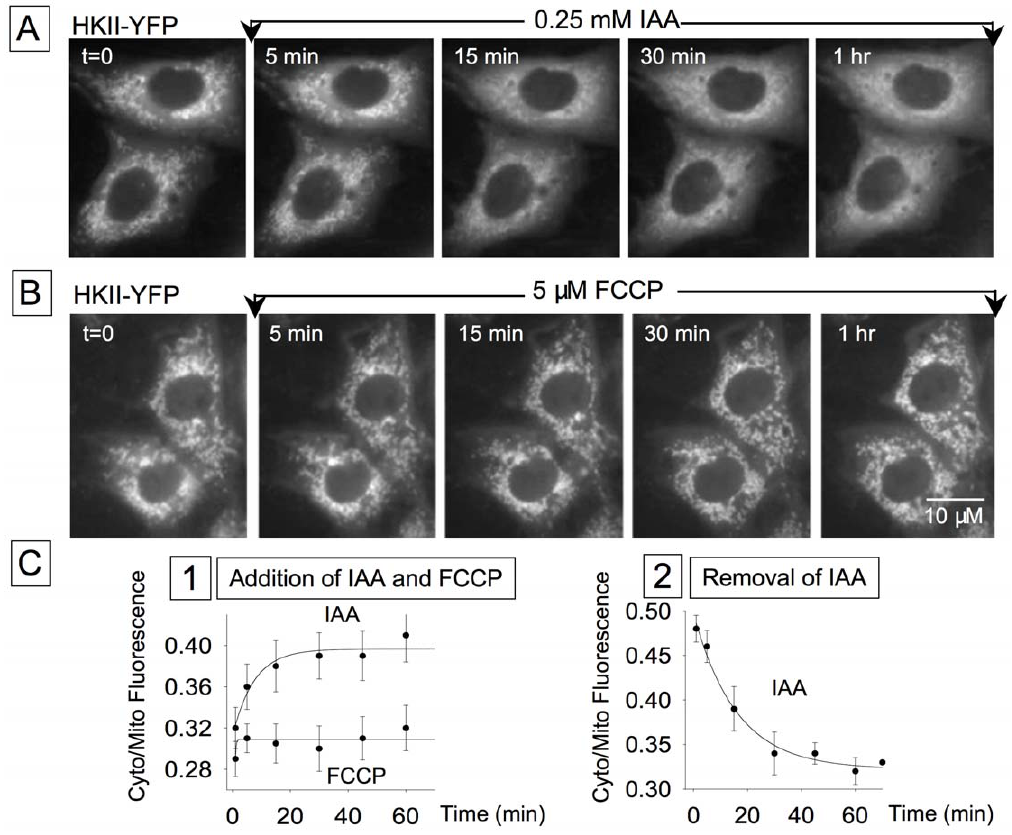
Figure 8. Rates of association and dissociation of HKI and HKII in response to glucose, IAA and FCCP. IAA, but not FCCP, facilitates HKII dissociation from mitochondria. Images in Panel A obtained with HKII-YFP expressed in CHO cells show that addition of the glycolysis inhibitor, IAA, in the presence of 10 mM glucose causes HKII dissociation from mitochondria within 5 to 15 min. In contrast, addition of FCCP, which depletes mitochondrial ATP, had no effect on HKII interaction with mitochondria (B). These data indicate that G-6-P, rather than ATP mediates the effect of glucose removal on HKII translocation. Panel C shows the rates measured as ratio of fluorescence intensity obtained from intracellular domains without and with mitochondria. C1 is a comparison of the rates of HKII dissociation from mitochondria in response to IAA and FCCP addition in the presence of 10 mM glucose outside. C2 illustrates the rate of reassociation HKII with mitochondria upon removal of IAA.